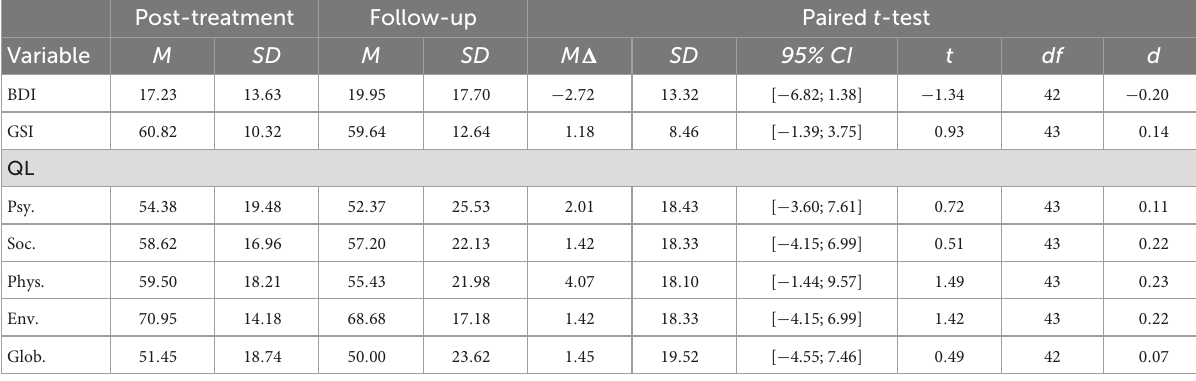
TABLE 4 Contrast of post-treatment with 3 months follow-up in study variables.